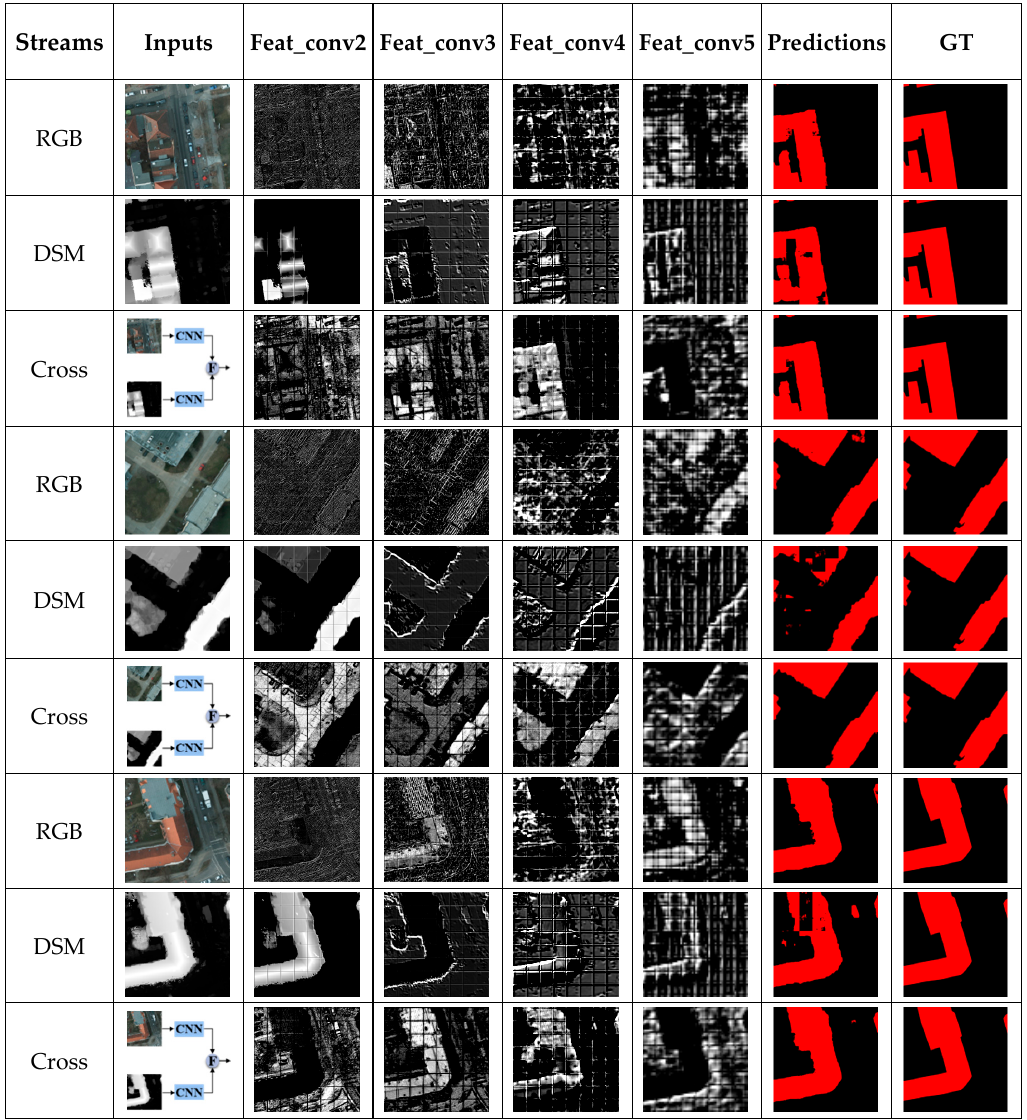
Figure 6. Visualized features in different layers and output predictions of RGB-specific, DSM-specific, and cross-modal streams. Feat_ n refers to the feature map derived from the n -th convolutional block.